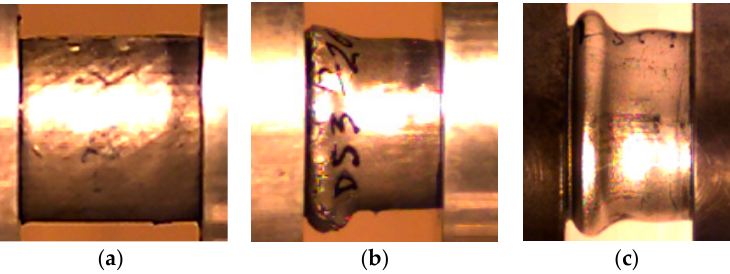
Figure 11. ( a ) View of initial samples; ( b ) final failure mode for AlSi12 DS20% foams; ( c ) final failure mode for Al6082-T4 DS20%